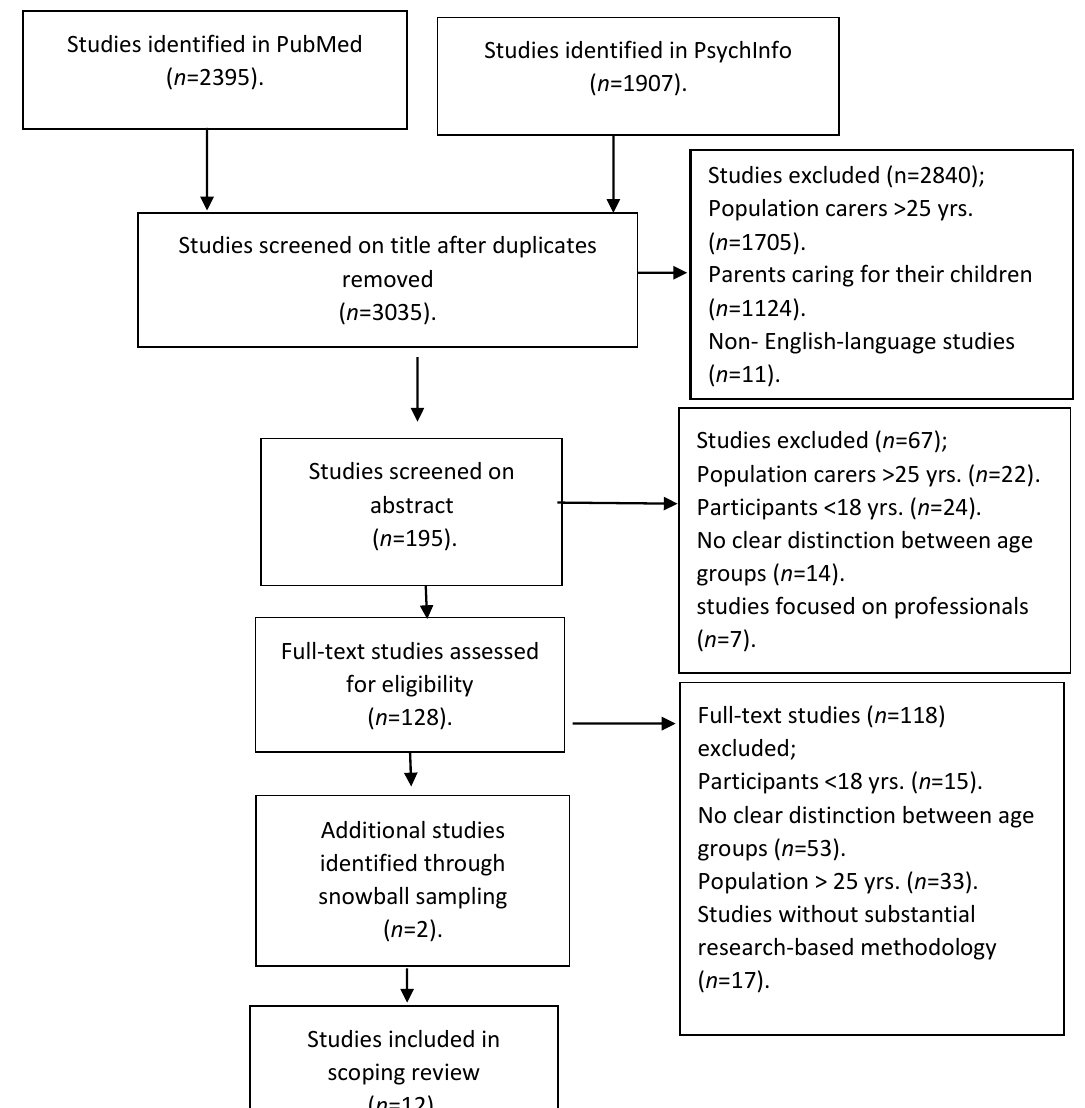
Figure 2. Flow chart; search strategy and number of records identified.